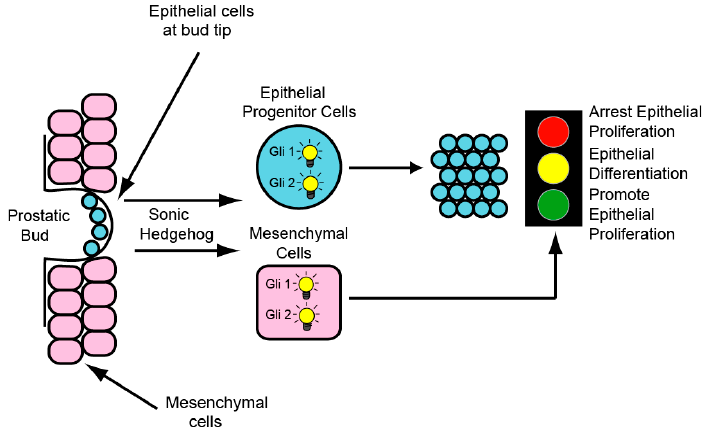
Figure 5. Hh signaling in the developing prostate involves both autocrine and paracrine signaling. Autocrine signaling drives proliferation of (androgen independent) progenitor cells at the bud tip. Paracrine signaling elicits a complex transcriptional response, determined by the stage of development, that exerts a variety of effects on epithelial proliferation and differentiation. In the prenatal prostate, Hh pathway activity drives epithelial proliferation and ductal growth. In the postnatal prostate, Hh pathway activity inhibits epithelial proliferation and ductal growth. Androgen independent progenitor cells generated by autocrine Hh signaling during development are able to survive castration and enable prostate regeneration in response to testosterone